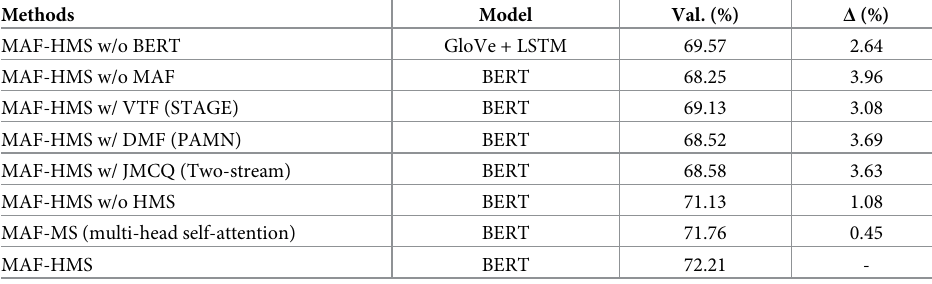
Table 2. Ablation study on model variants of MAF-HMS on the validation set of TVQA.